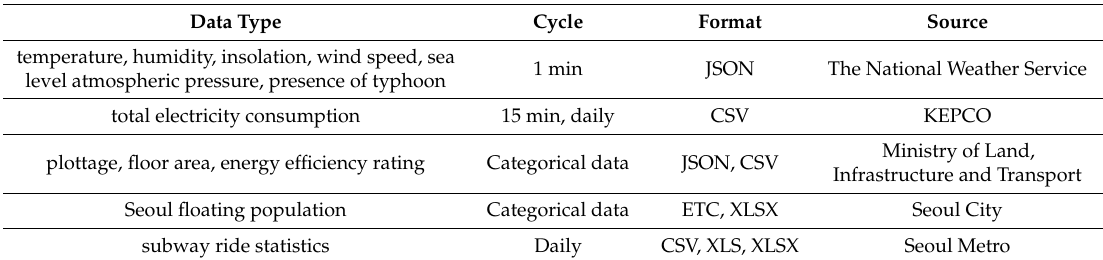
Table 1. Example of open data provided from Korean government.